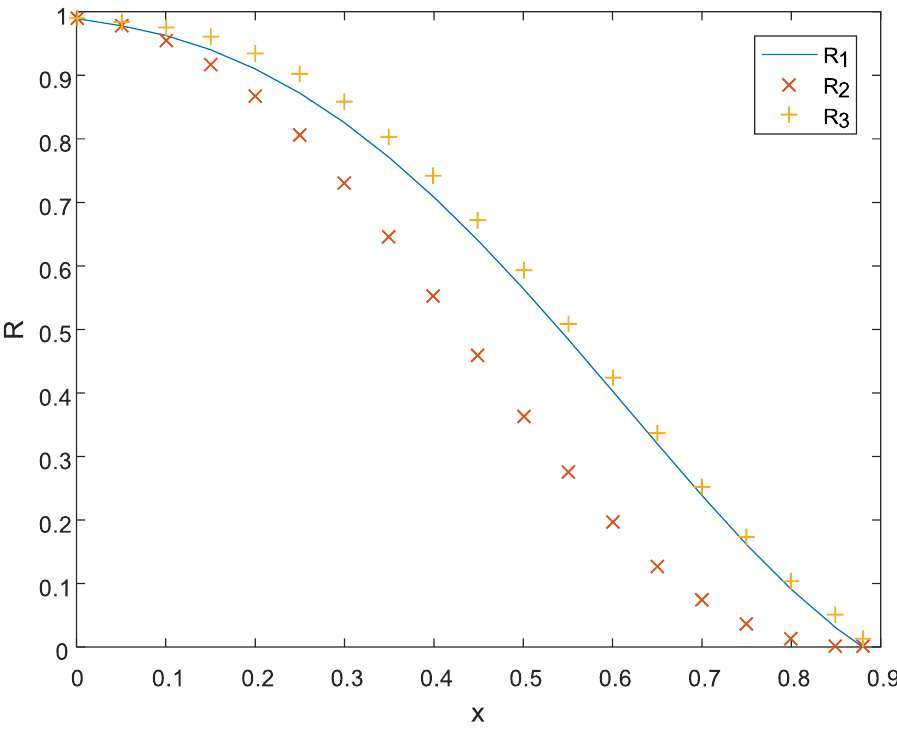
Figure 1. The change in the value of R(20) due to changes in p 1 , p 2 , p 3 , k cf =3, n 1 =5, n 2 =9, n 3